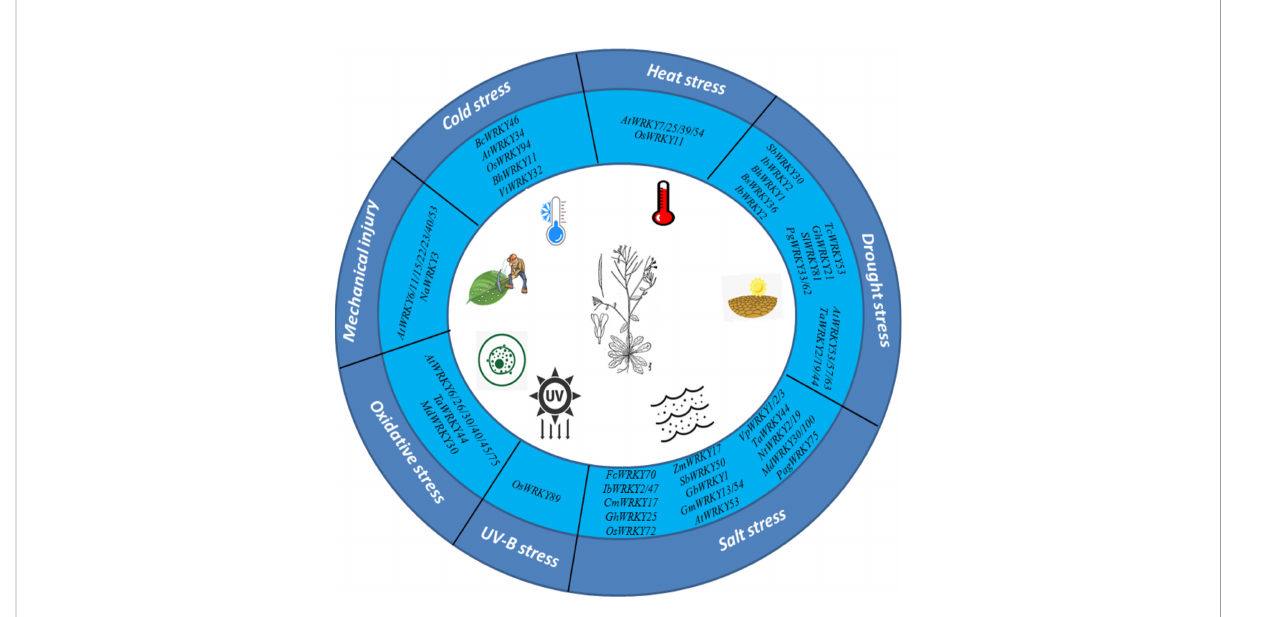
FIGURE 4 WRKY-TFs response to various abiotic